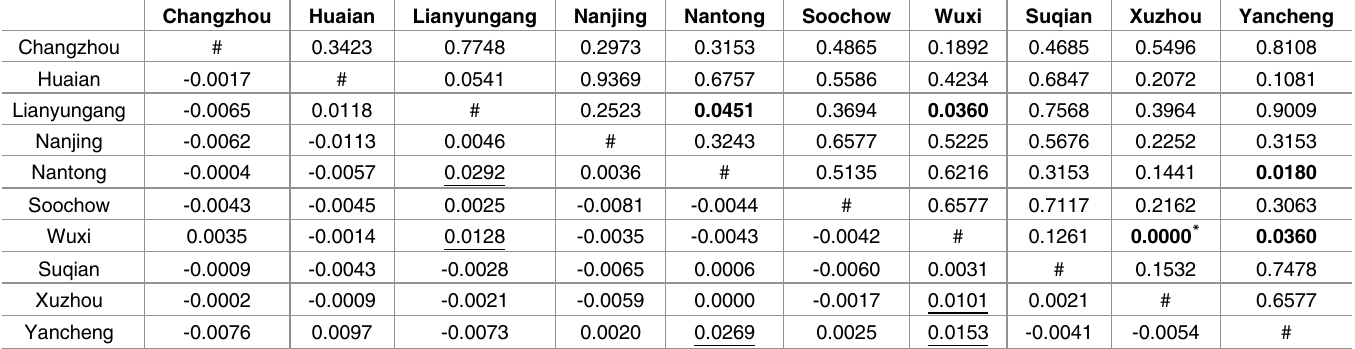
Table 1. The pairwise R ST and p values among various Han populations from 10 prefecture-level cities in Jiangsu province excluding Zhenjiang, Yangzhou, and Taizhou